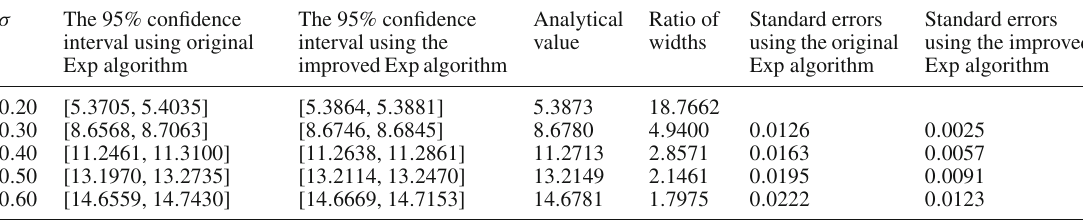
Table 4 95% confidence interval for the up-and-out put barrier option under the CEV model with β = 0, M = 10 6 and (cid:7) t = E [ δ t ] = 0 . 002 σ The 95% confidence interval using